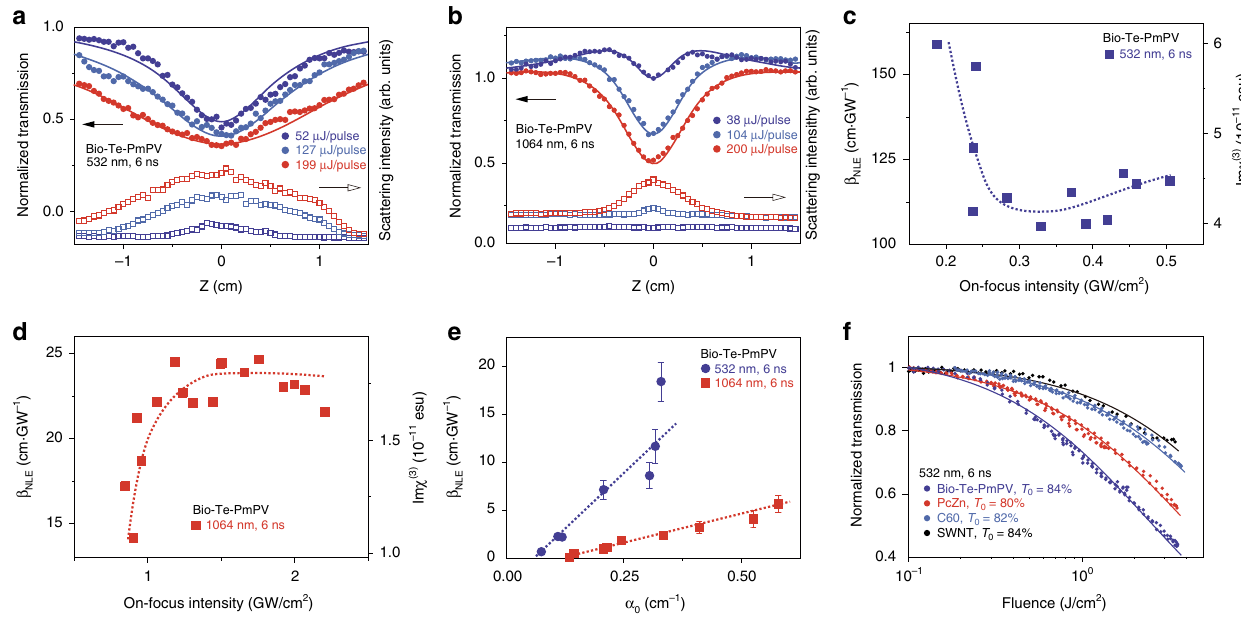
Fig. 3 Nonlinear optical responses to ns pulses. a , b Circles: normalized transmission of Bio-Te-PmPV as a function of z at 532 nm and 1064 nm; Squares: light intensity scattered by the sample at 35 degrees to the laser ’ s direction; Lines: z-scan fi tting results. c , d Effective nonlinear extinction (NLE) coef fi cient β Im χ (3) as a function of on-focus intensity for ns pulses at 532/1064 nm. e Effective nonlinear extinction coef fi cient β NLE and corresponding function of linear absorption coef fi cient α 0 with error bars indicating s.e.m. f Comparison of optical limiting performance of Bio-Te-PmPV, PcZ n ( t